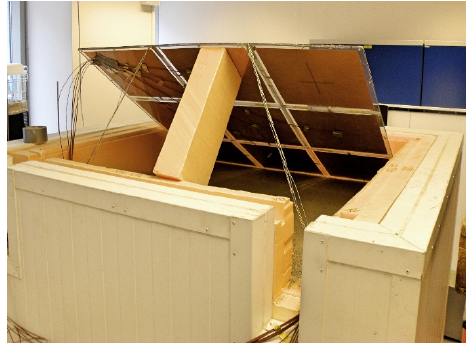
Figure 12. Heat flux plates at the top of the sample (Rieksts et al., 2017 [27]).